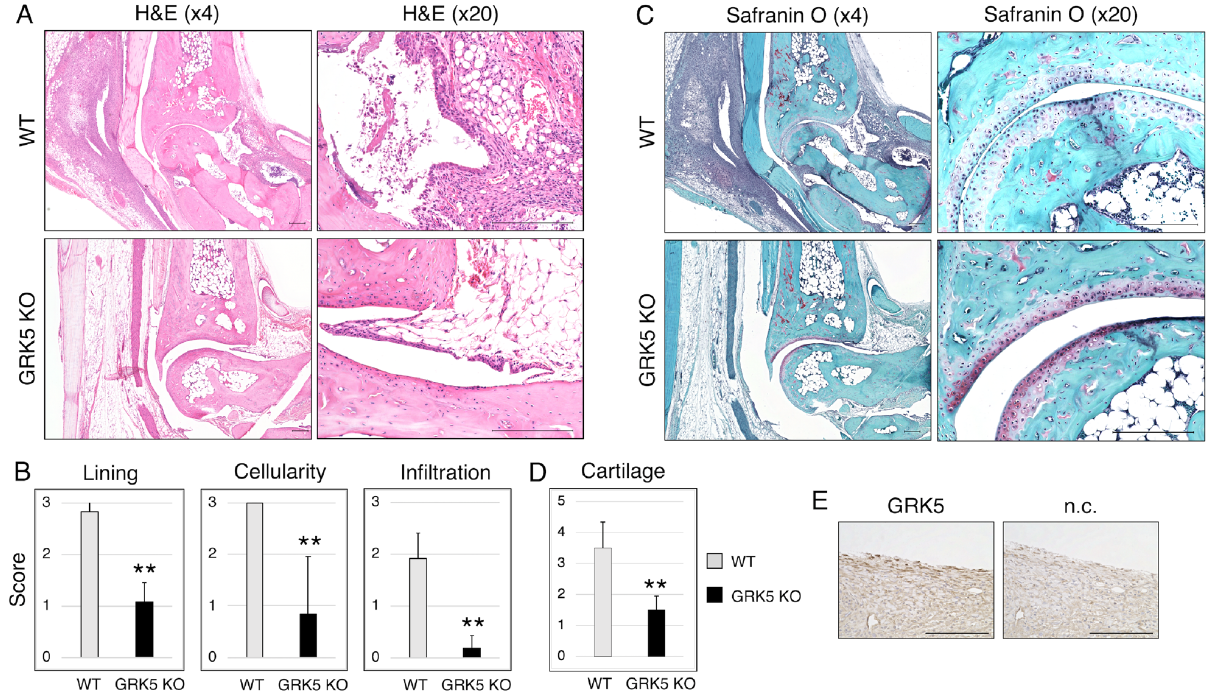
Figure 4. Histological effects of GRK5 knockout on synovitis and cartilage degradation in a murine model of CAIA. ( A , C ) Histological assessment of sagittal murine ankle sections with ( A ) haematoxylin and eosin ( H , E ) staining and ( C ) safranin-O and fast green (Safranin O) staining. Scale bars = 200 μm. ( B ) Degree of synovitis in the two groups. The synovitis score divided into three categories using Krenn’s synovitis scoring system. Lining means hyperplasia or enlargement of the synovial lining layer. Cellularity means activation of resident cells or pannus formation. Infiltration means inflammatory infiltration. Values are means ± SD (n = 4). ** P < 0.01 versus WT mice. ( D ) The degree of cartilage degradation was compared using Safranin O staining. Values are means ± SD (n = 4). ** P < 0.01 versus WT mice. ( E ) Representative immunohistochemical staining for GRK5 in CAIA WT mice. Inflammed synovium in ankle section was stained. Scale bar = 100 μm.